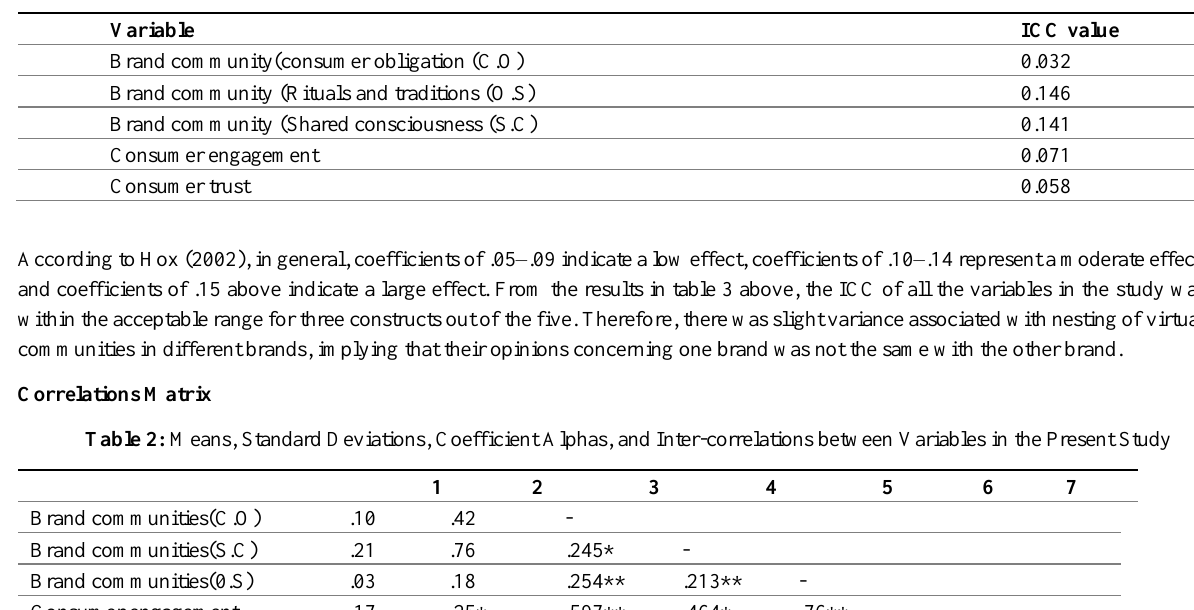
Table 1: Intra-class Correlation Coefficients of the Variables